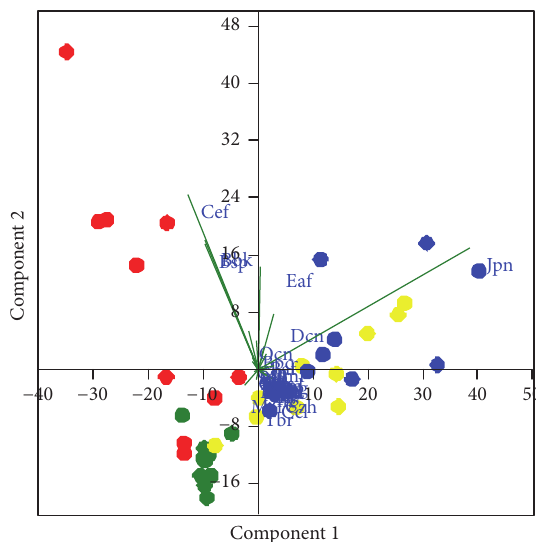
Figure 4: Biplot of the Principal Components Analysis for the variables (species) quantified across the plots, (young fallows: green; medium fallows: yellow; old fallows: blue; and mature forests: